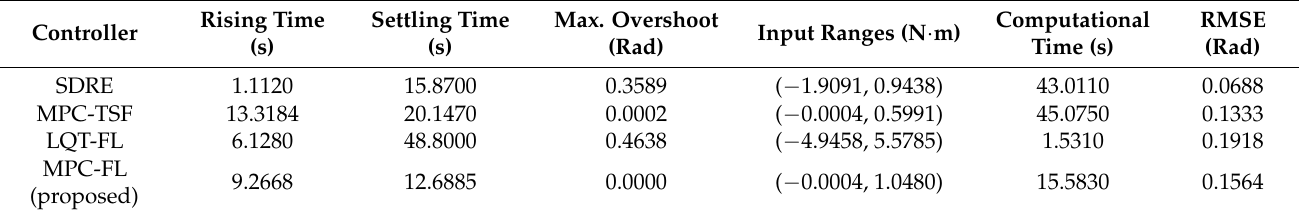
Figure 3. Flexible-joint mechanism by applying the four control schemes without input constraints: ( a ) output responses; ( b ) input signals. Table 3. Performance comparisons of applying the four control schemes to the flexible-joint mecha- nism without input